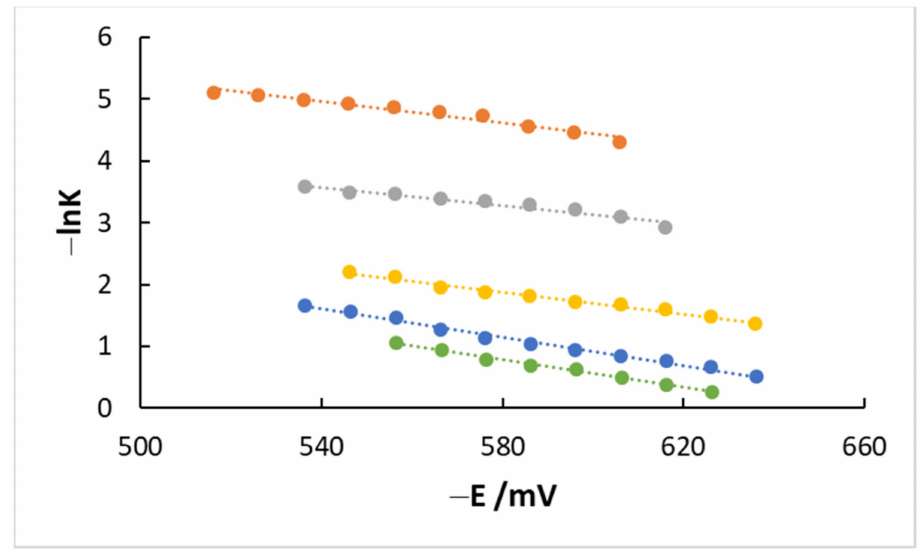
Figure 5. Plot of − lnK (obtained from p (cid:48) values) vs. E at different TEA concentrations (mM): 0 (green), 0.75 (blue), 2 (yellow), 5 (grey), 10